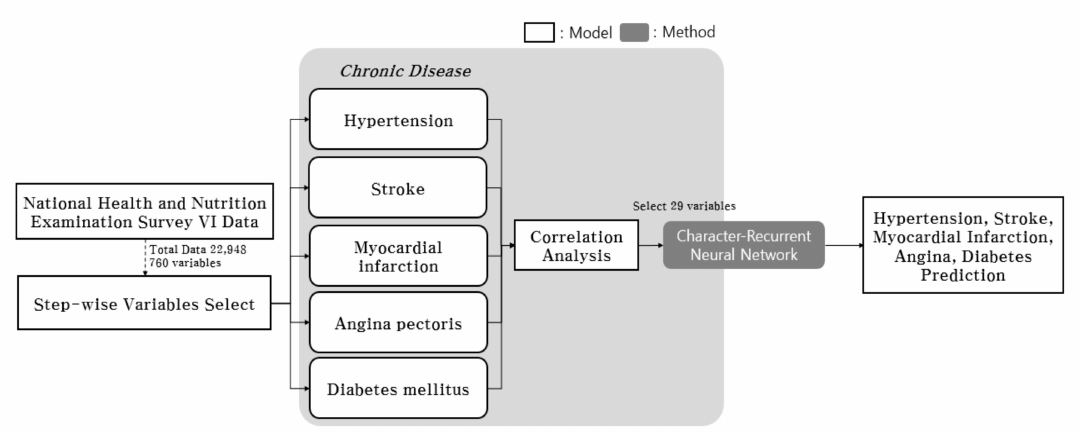
Figure 2. Overview of proposed procedure using character-recurrent neural network